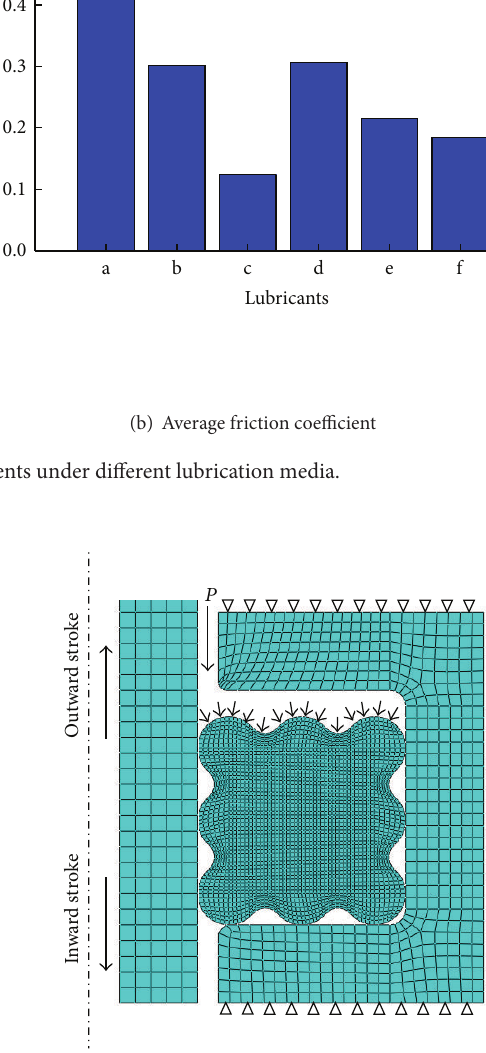
Figure 5: Finite element